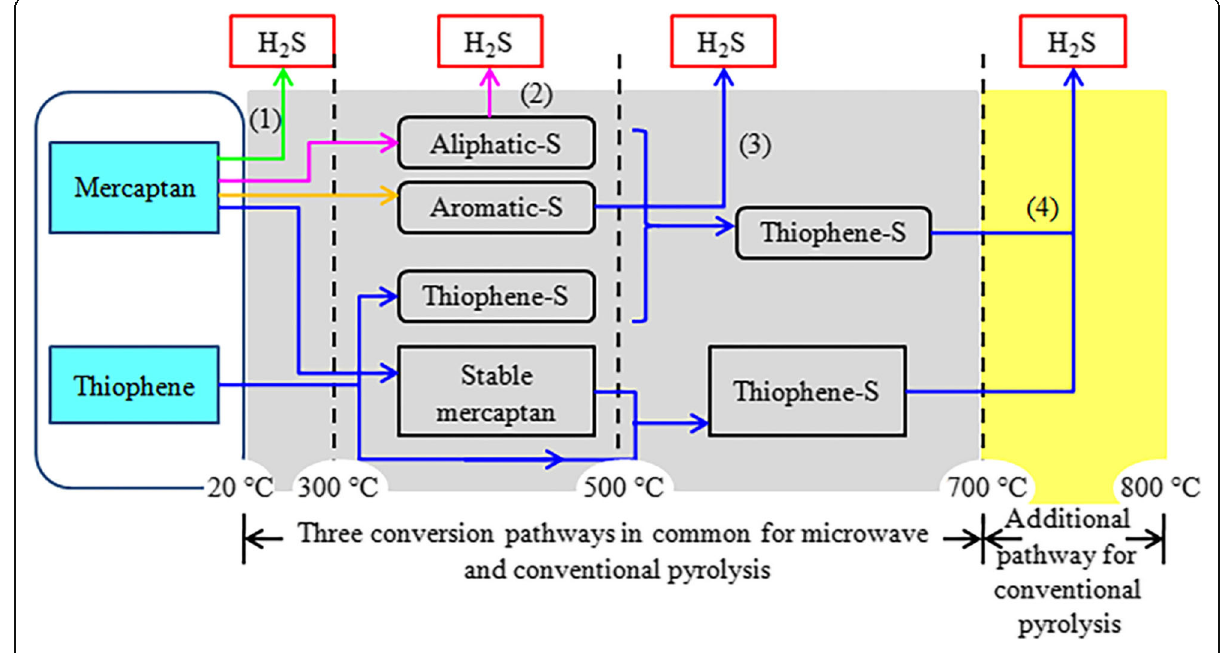
Fig. 3 Sulfur transformations in the pyrolysis processes